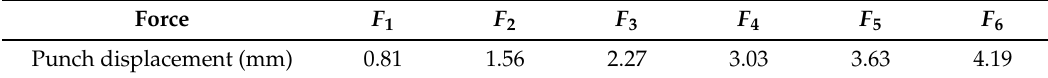
Table 3. Forces F 1 to F 6 and corresponding punch displacements.